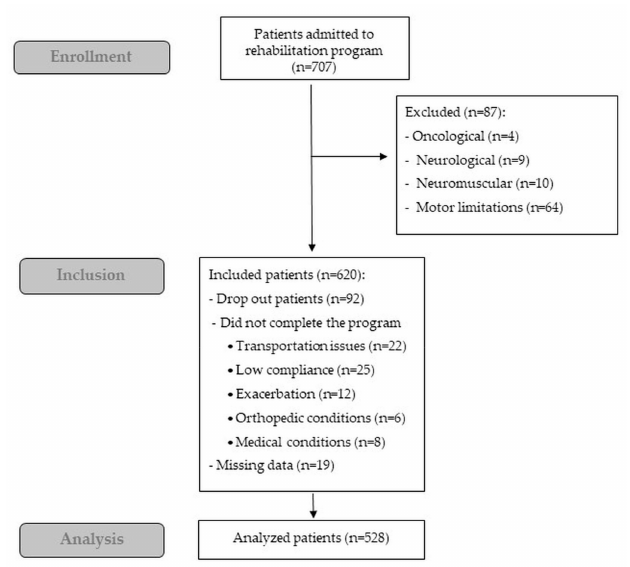
Figure 2. Flow diagram of the study. Table 1. Demographic, anthropometric, physiological, and clinical characteristics of patients. Data are expressed as number (%) or mean